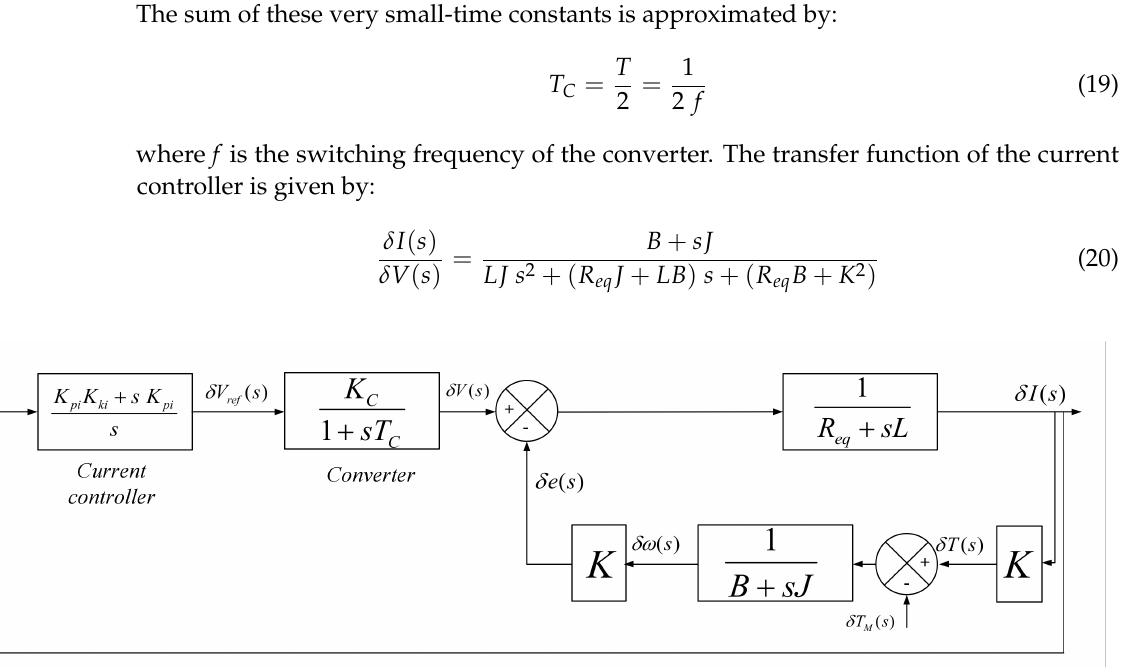
Figure 5. Schematic diagram of the linearized